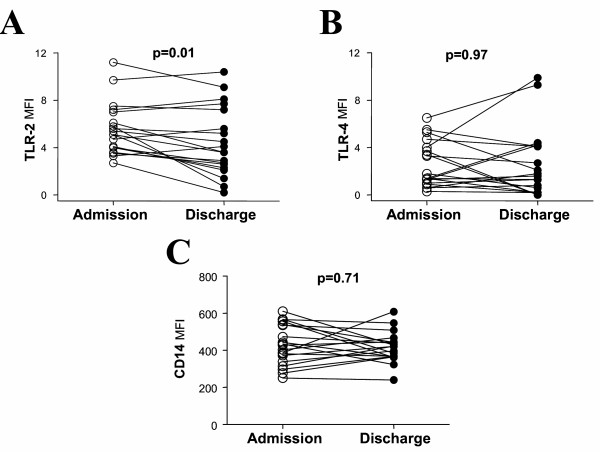
Analysis of TLR-2 (panel A), TLR-4 (panel B) and CD14 (panel C) expression in peripheral blood monocytes from AECOPD patients at admission (open circles) and hospital discharge (black circle). The results were analyzed by paired two-tailed t test.